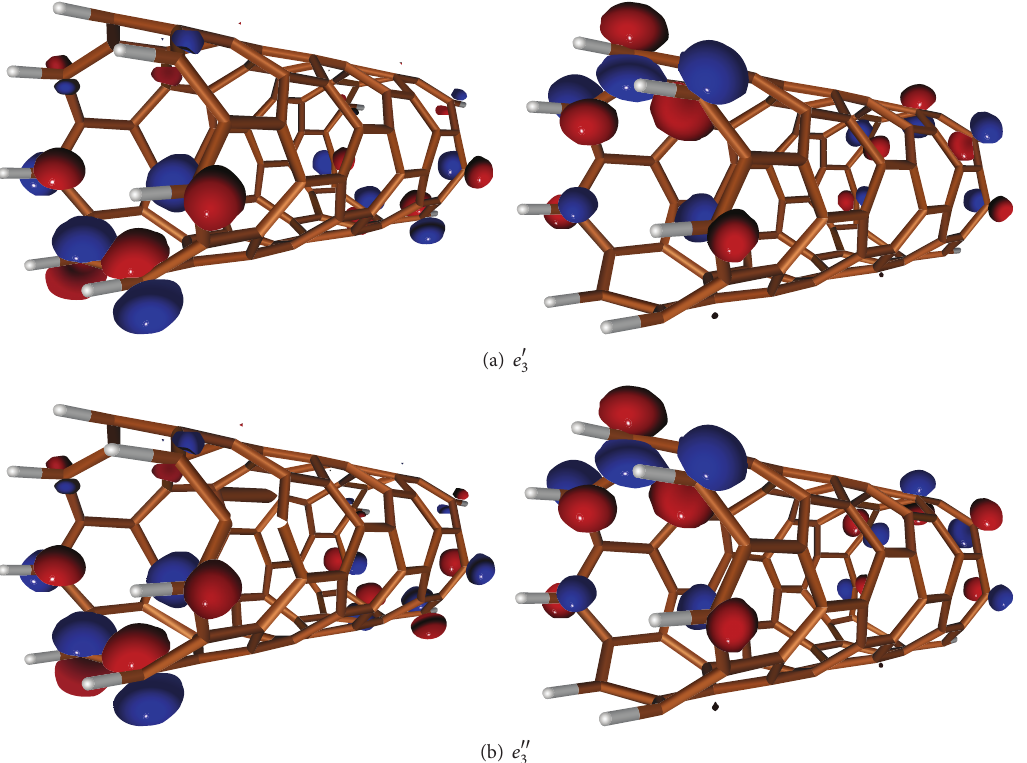
Figure 9: Active orbitals for nanotube 7 5 as an example of nanotubes with 𝑛 odd and 𝑝